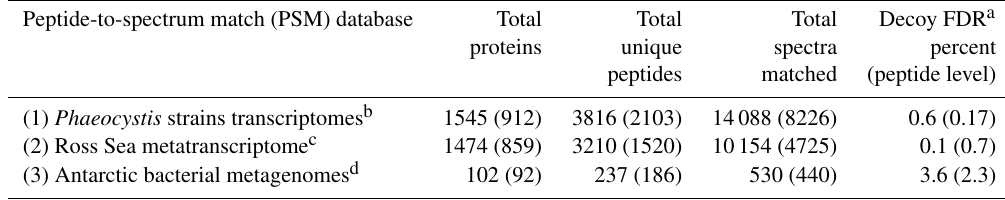
Table 2. Comparison of the total number of proteins, peptides, and spectra measured in the Ross Sea metaproteome net tow sample using three databases for peptide-to-spectrum matching (see Table S2). Results from two-dimensional and one-dimensional (1-D in parentheses) analyses are shown.